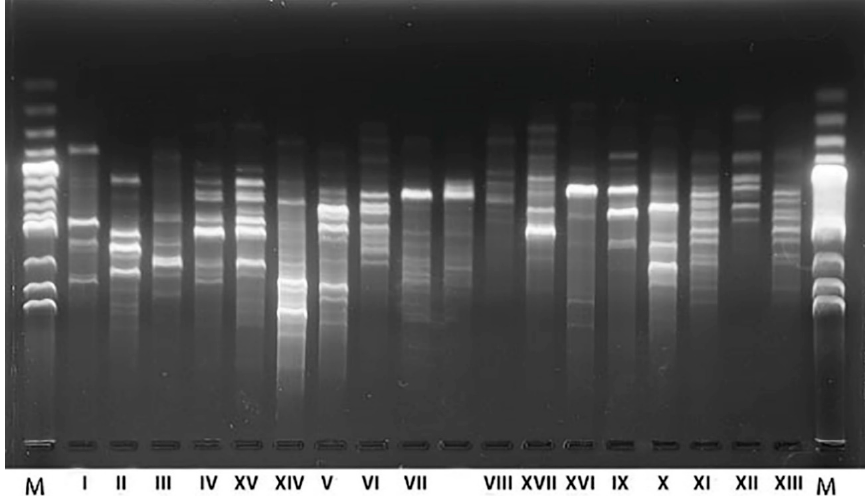
Figure 2. Results of electrophoresis of RAPD-PCR products with M13 starter of yeast isolates from fermenting sauerkraut.